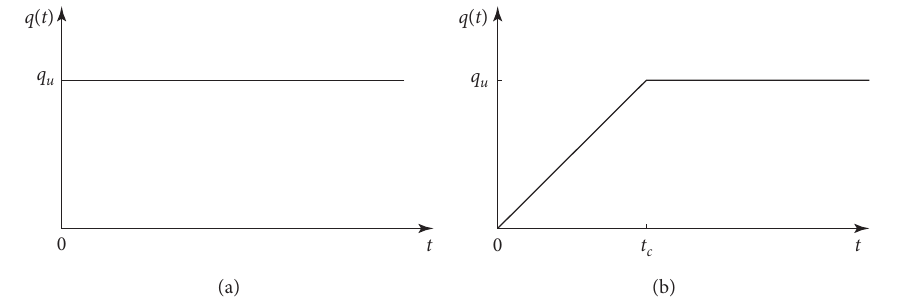
Figure 3: Constant loading (a) and ramp loading (b).